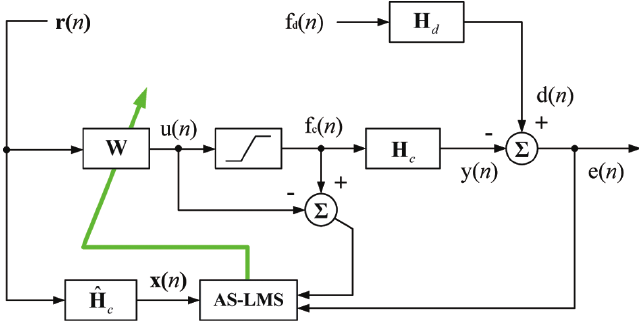
Fig. 2. Structure of an adaptive control